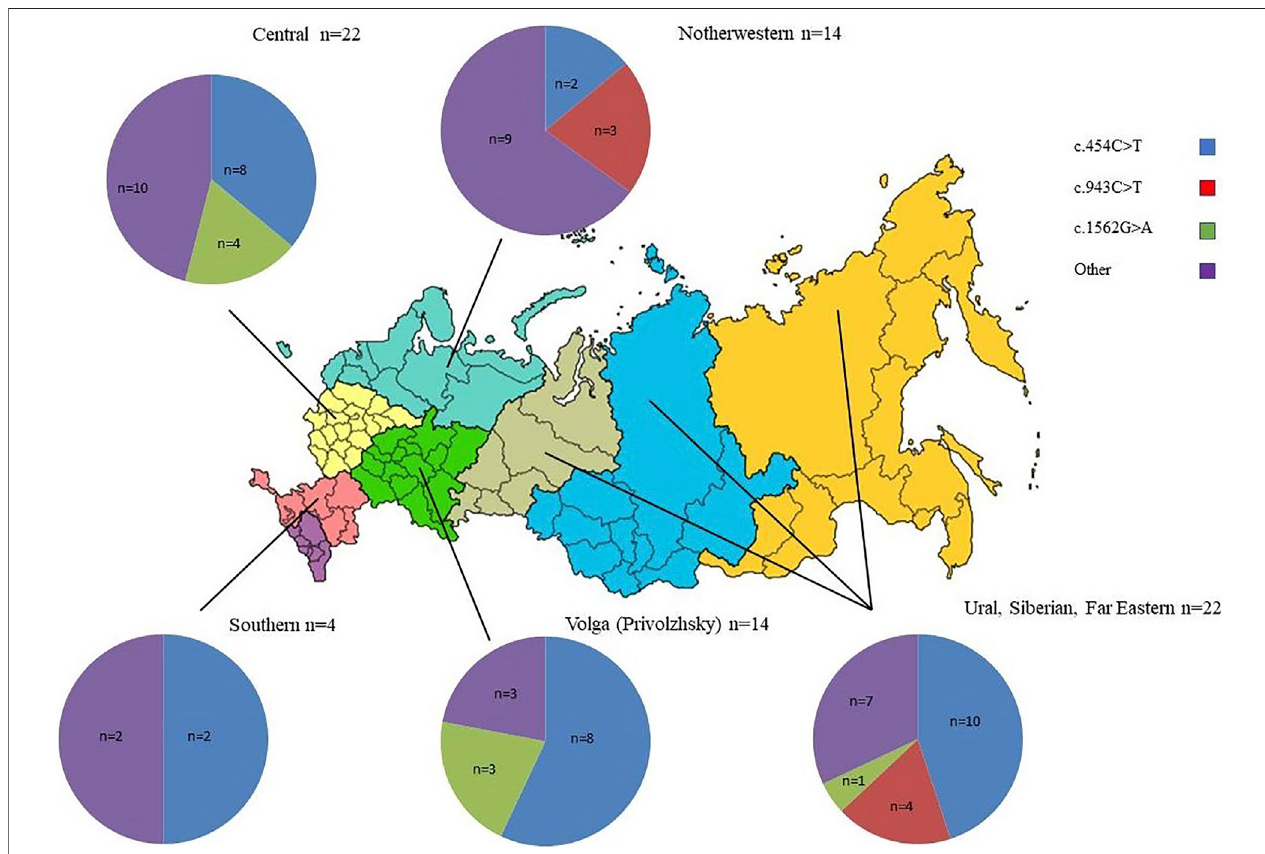
FIGURE 2 | Distribution of frequent pathogenic ARSB alleles among Slavic Russian patients from different districts of the RF. n — number of ARSB